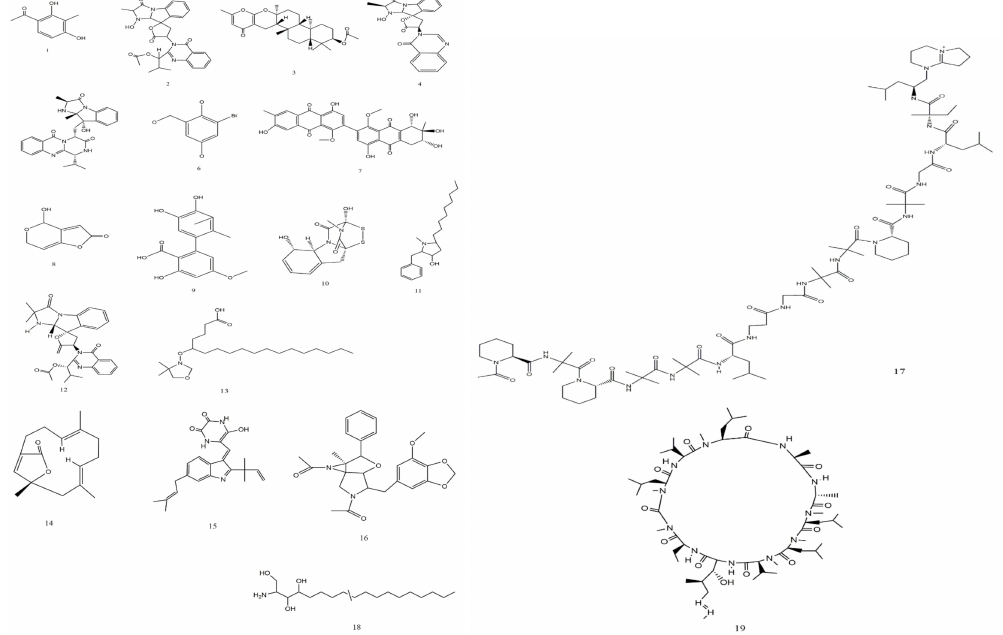
Figure 5. Chemical structure of some compounds from fungi with anti-cancer